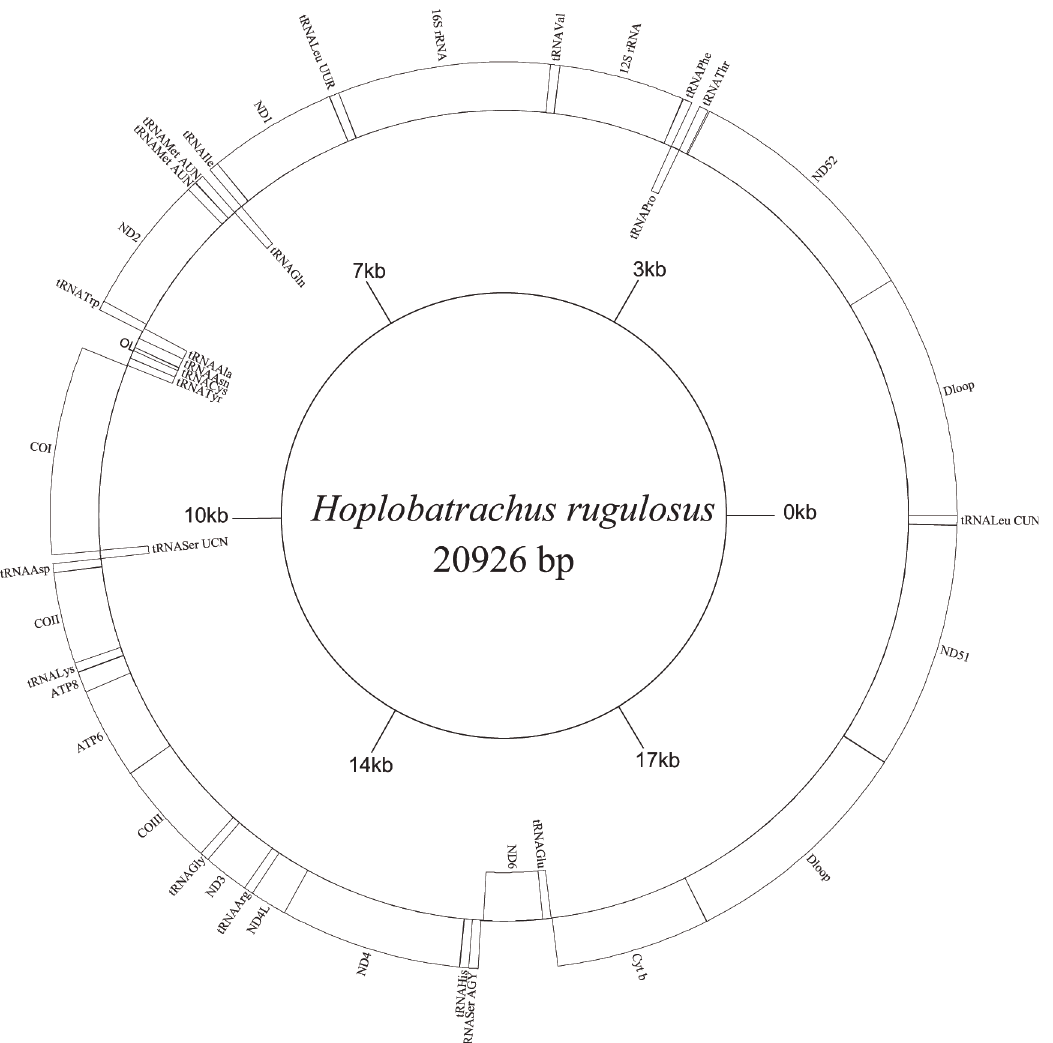
Fig 1. Mitochondrial map of H . rugulosus bred type. tRNAs are labeled according to the three letter amino acid codes. Gene name inside indicates the direction of transcription from left to right, and gene name outside indicates right to left.